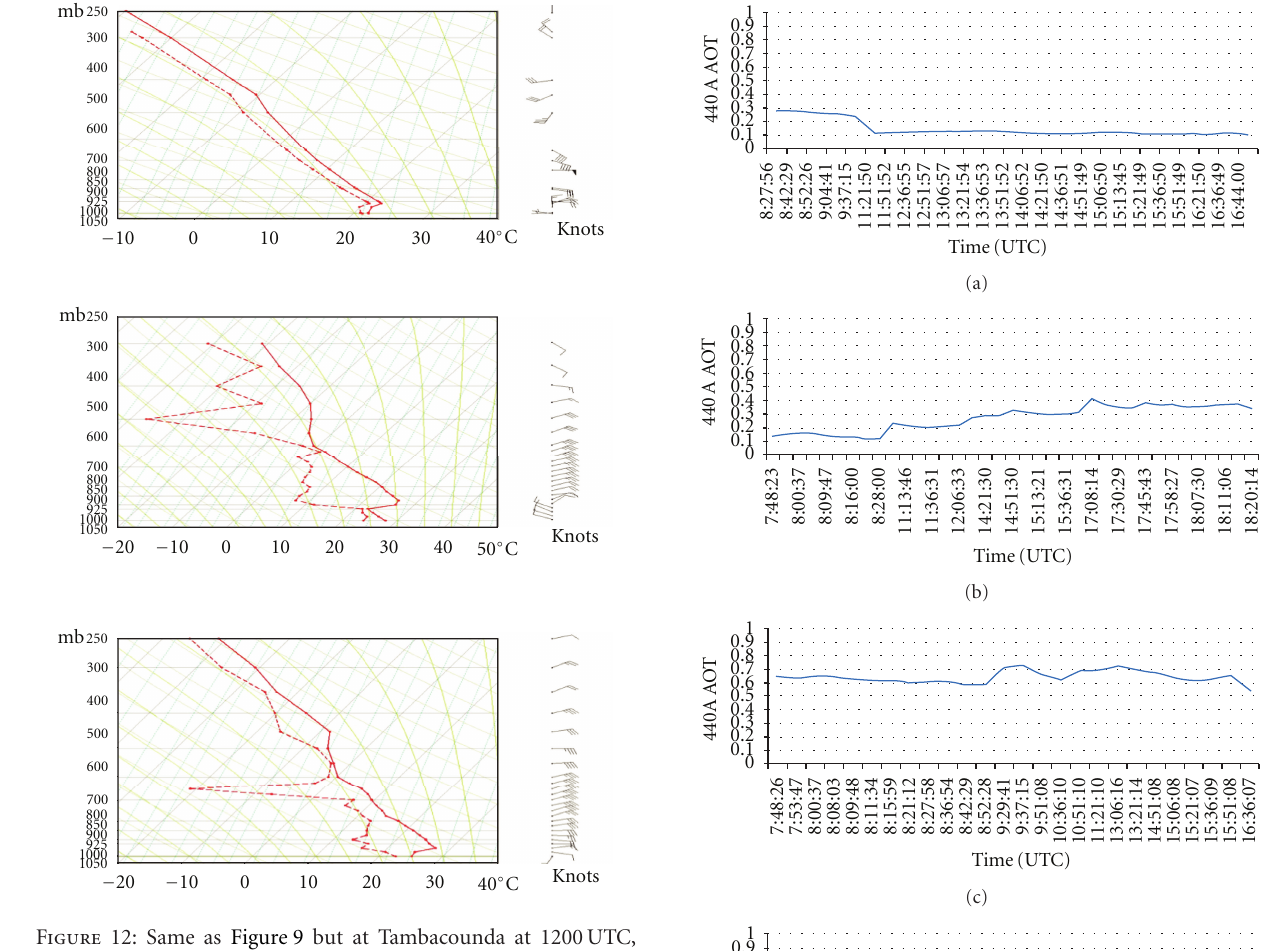
Figure 12: Same as Figure 9 but at Tambacounda at 1200 UTC, Dakar at 1200 UTC, and Kawsara at 1402 UTC on 11 September 2006.